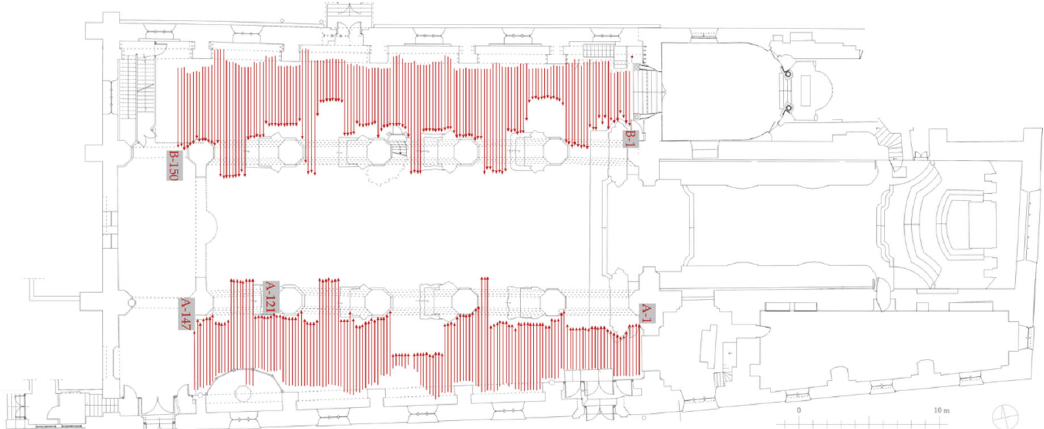
Figure 6. Plane view of the church with ground penetrating radar (GPR) traces in the south (traces A ‐ 1 to A ‐ 147) and north (traces B ‐ 1 to B ‐ 150)